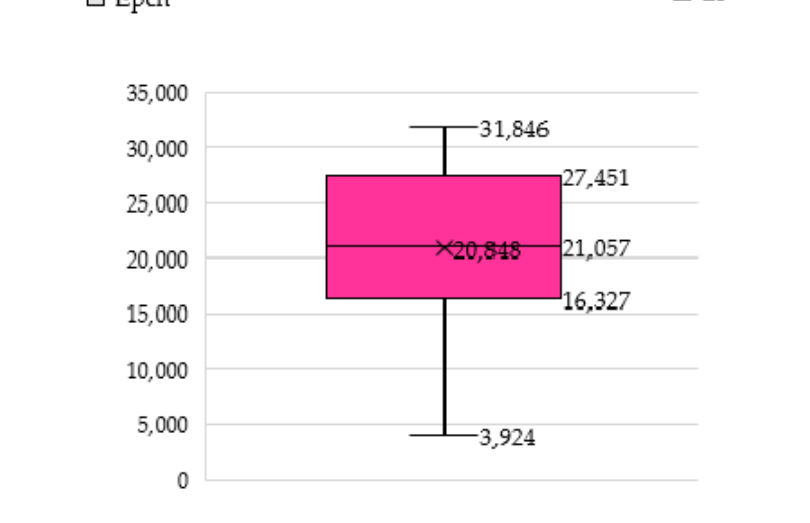
Figure 7. Total energy accumulated in the natural and mineral fertilizers, plant protection products, and seeds used [MJ · ha − 1 ]. Source: own study.